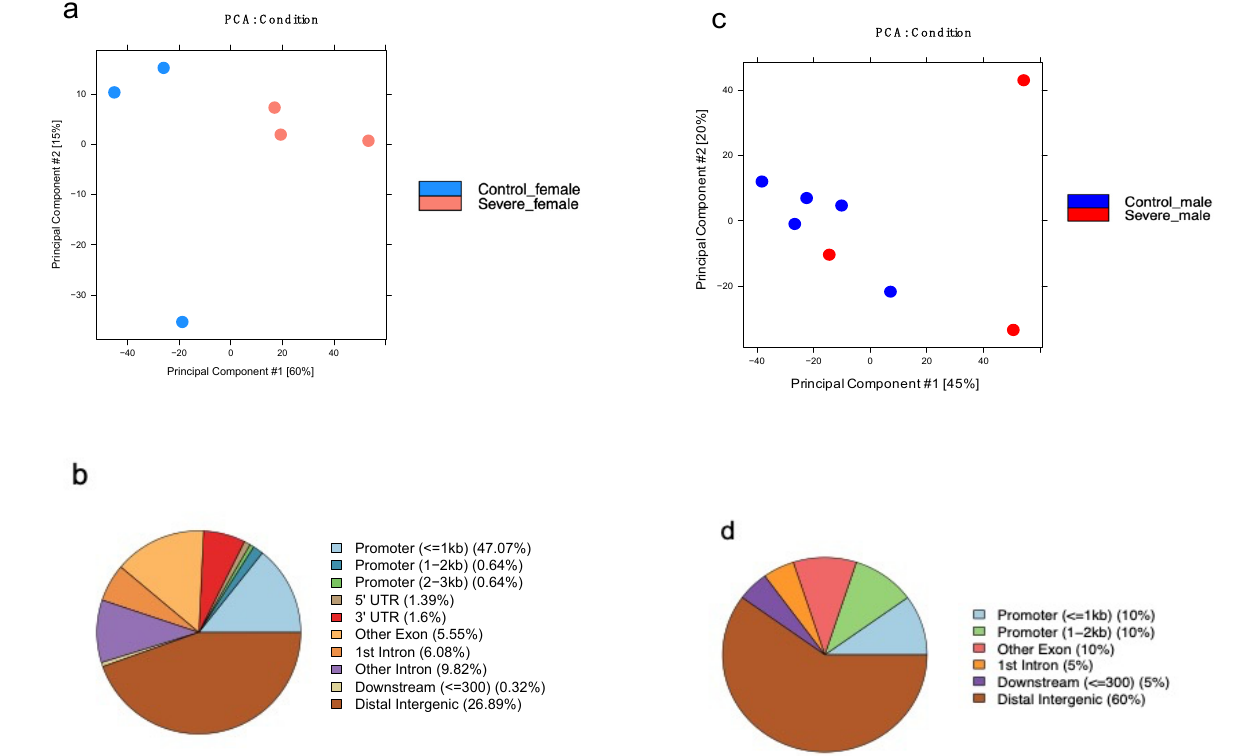
Figure 5. Differential analysis of H3K27me3 profiles based on sex. ( a ) Principal component analysis using TMM normalized read counts of 33,537 regions of female H3K27me3 profiles. Samples are colored based on group (Control in blue, severe AD in red). ( b ) Pie-chart showing the annotation of 301 DE sites of H3K27me3 found after DE analysis for the female group. ( c ) PCA conducted using TMM normalized reads count across 43,397 regions of male H3K27me3. Samples are colored based on group (Control in blues, severe AD in red). ( d ) Pie-chart showing the annotation of 20 DE sites of H3K27me3 found after DE analysis for the male group.